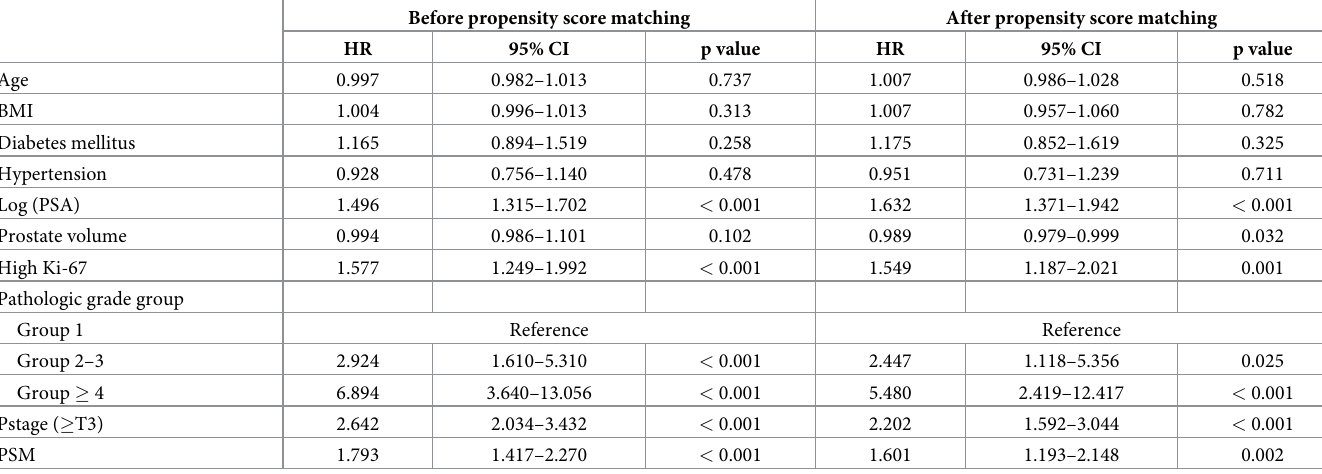
Table 3. Multivariate analyses using Cox proportional hazard model on biochemical recurrence after propensity score matching (Ki-67 as categorical variable). Before propensity score matching After propensity score